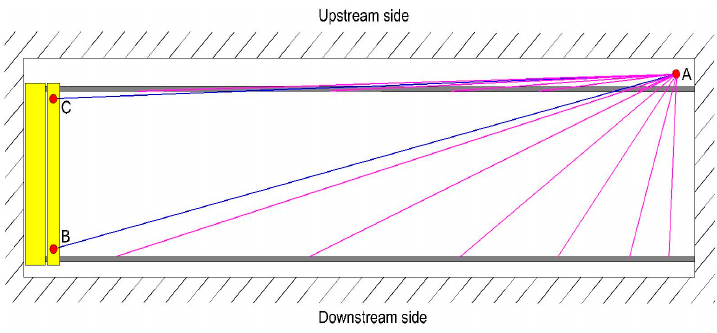
Figure 4. The classic TPS method for measuring crane rails.